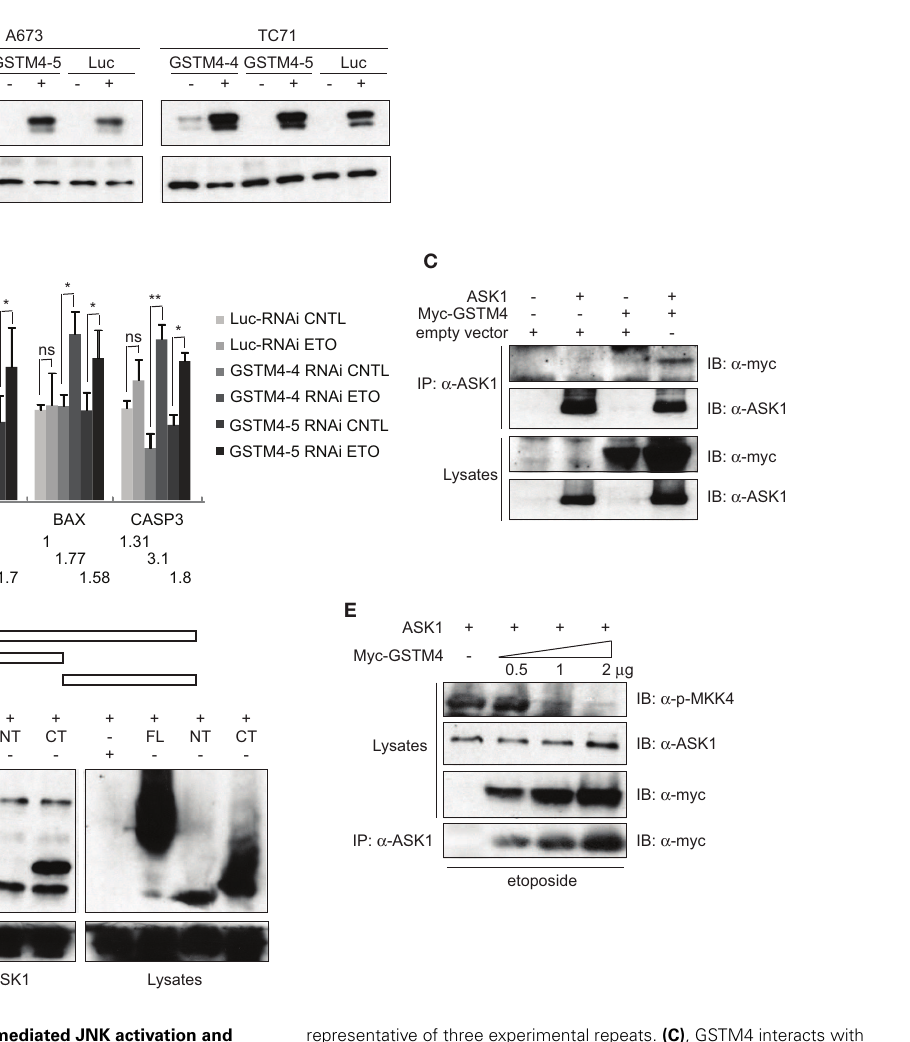
FIGURE 3 | GSTM4 inhibits etoposide-mediated JNK activation and apoptosis by interacting withASK1 . (A) Decreasing GSTM4 levels increases JNK activation induced by etoposide. Control- (Luc-RNAi) and GSTM4-silenced (GSTM4-4-RNAi and GSTM4-5 RNAi) cells were treated with or without etoposide (20 µ g/ml) for 3h. Cell lysates were subjected to JNK immunoprecipitation and JNK kinase assays using c-jun as